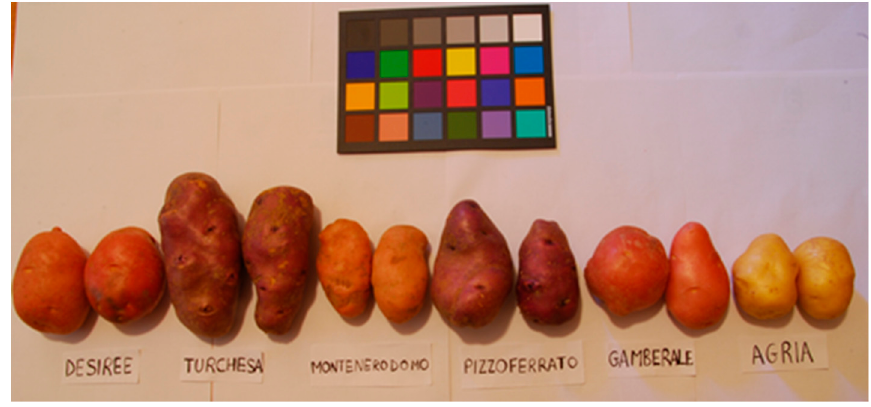
Figure A1. Tubers of some of the investigated potato accessions .